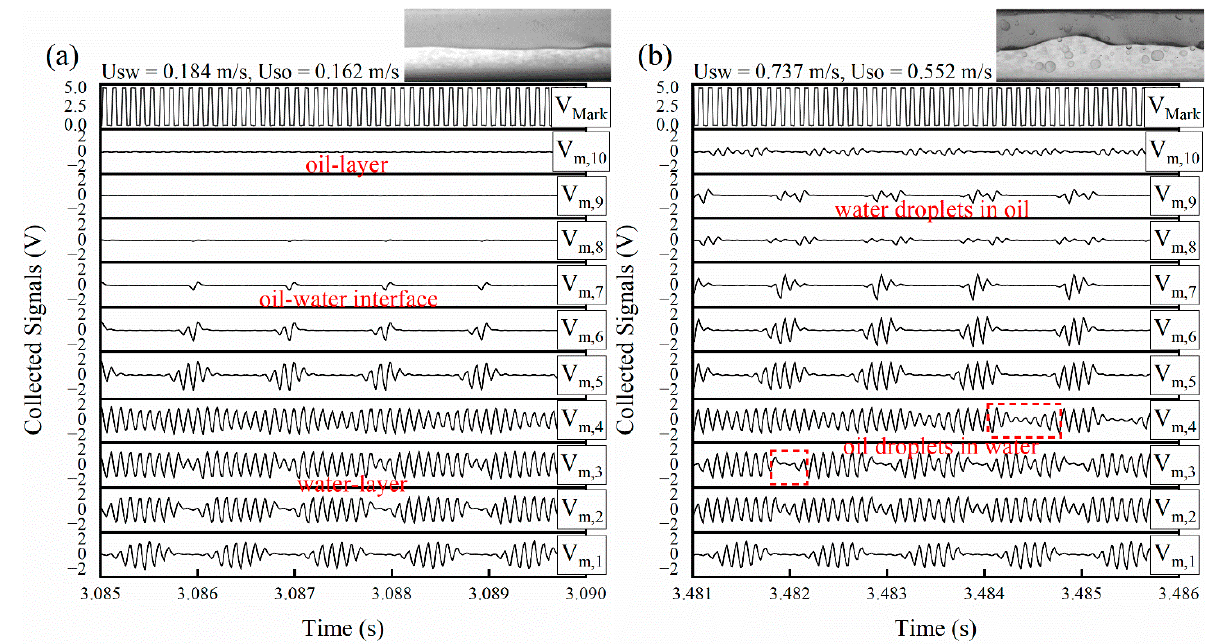
Figure 8. Response signals of the wire ‐ mesh sensor (0°): ( a ) ST; ( b ) D W/O&D O/W.